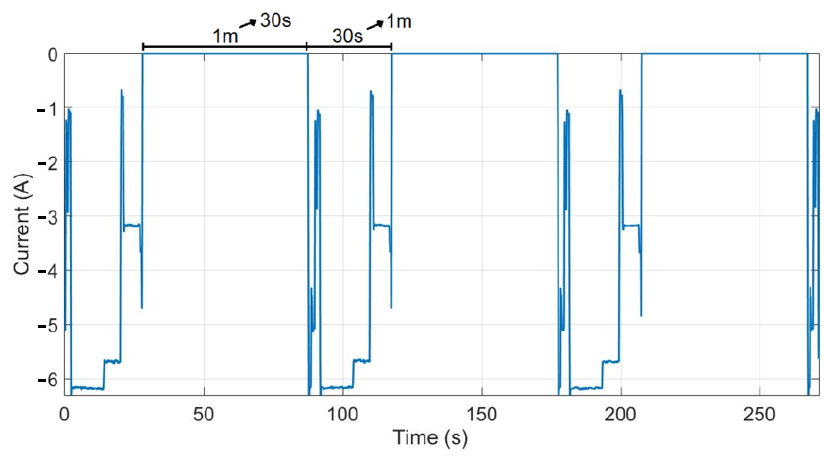
Figure 11. Short current pulses, where the currents are different from 0, with longer bursts. The battery parameters in all these experiments used the Nonlinear Grey Box model previously presented in Section 3.2.4. The purpose here is to define the best experiment design for battery parameter estimation, that will be capable to be a better fit in the highest number of different experiment design. The various fit levels in all these experiments are presented in Table 7. In this table, the first column indicates the experiment that was used for estimation, and the other columns indicate the experiment used for validation. Table 7. Comparison between all experiment data, regarding estimation data and validation data. Estimation Data in